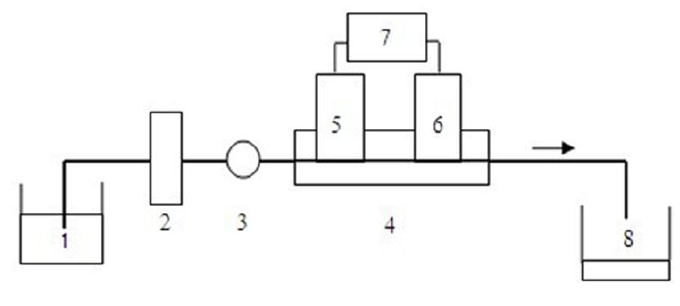
Figure 1. Schematic diagram of the flow monitoring system: (1) sample solution; (2) peristaltic pump; (3) membrane holder; (4) flow cell; (5) ammonium-selective electrode; (6) reference electrode; (7) ion analyzer; (8)